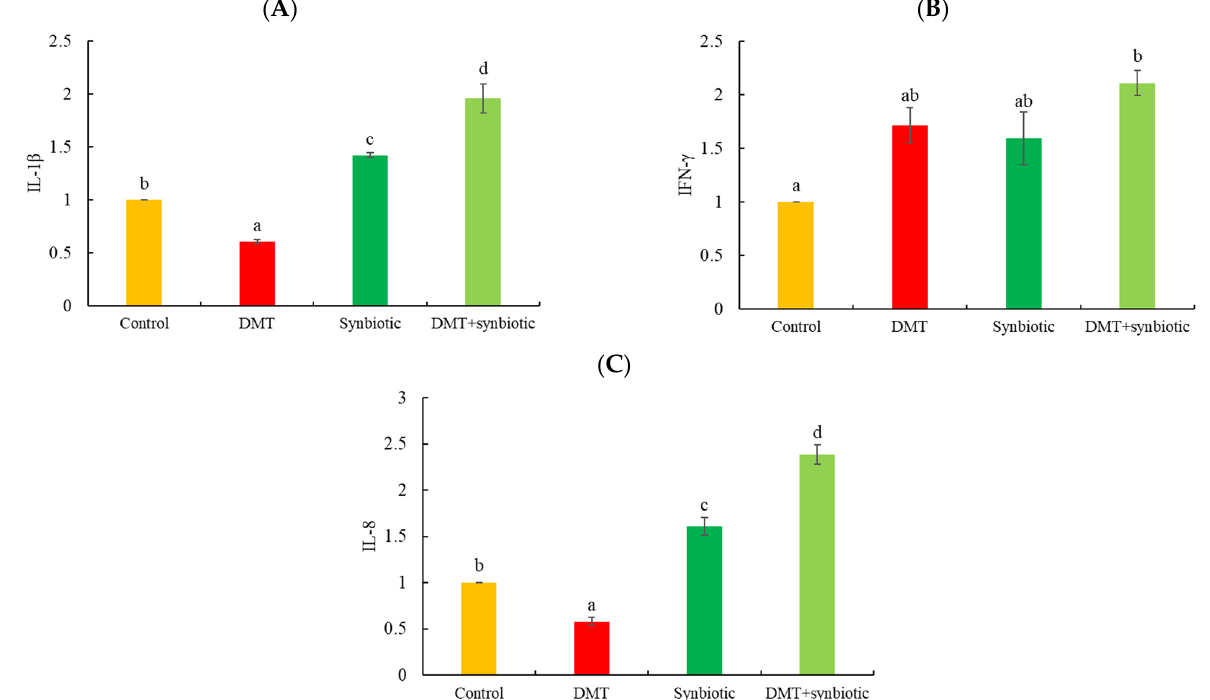
Figure 8. Transcription of ( A ) interleukin 1 β (IL-1 β ), ( B ) interferon-gamma (IFN- γ ), ( C ) interleukin 8 (IL-8) in Nile tilapia treated with deltamethrin (DMT) with synbiotic feeding. Bars represent mean ± SD (n = 3), and different letters show significant differences ( p < 0.05).